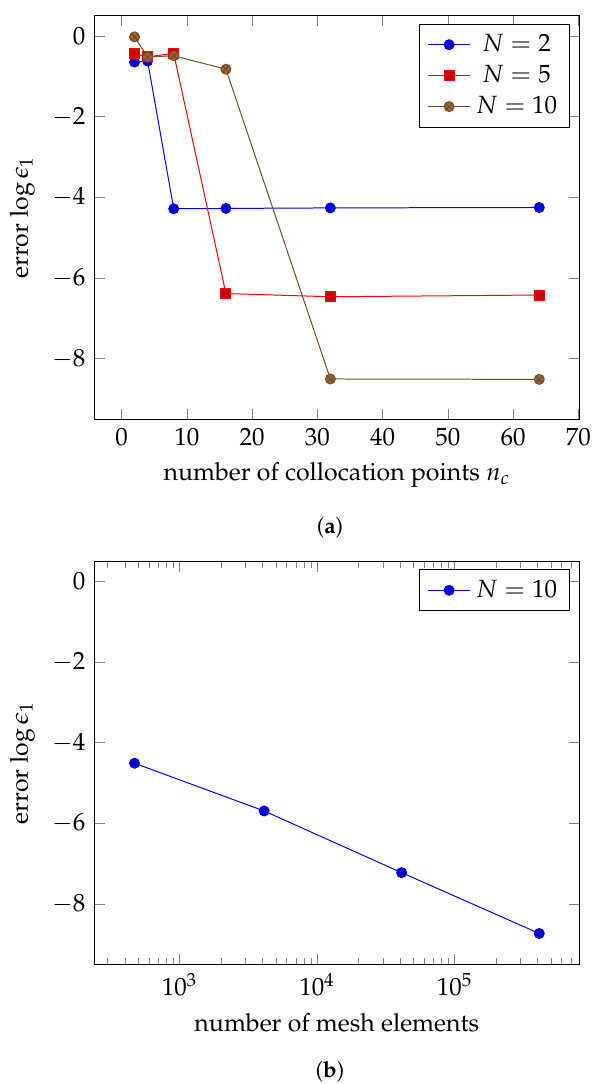
Figure 5. log (cid:101) 1 with our method based on the Green’s function compared to that obtained with the finite elements method. ( a ) log (cid:101) 1 as a function of n c for a fixed number of terms in the Laurent expansion N = 2, N = 5 or N = 10; ( b ) log (cid:101) 1 as a function of the number of mesh vertices for the finite element method with Lagrangian elements of order